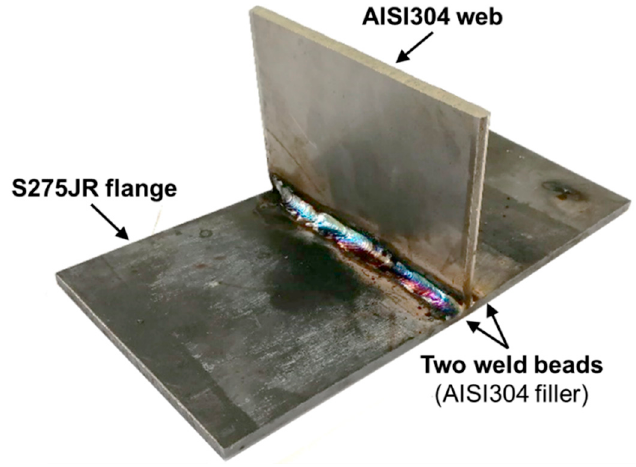
Figure 1. AISI 304-S275JR steel T-joint.